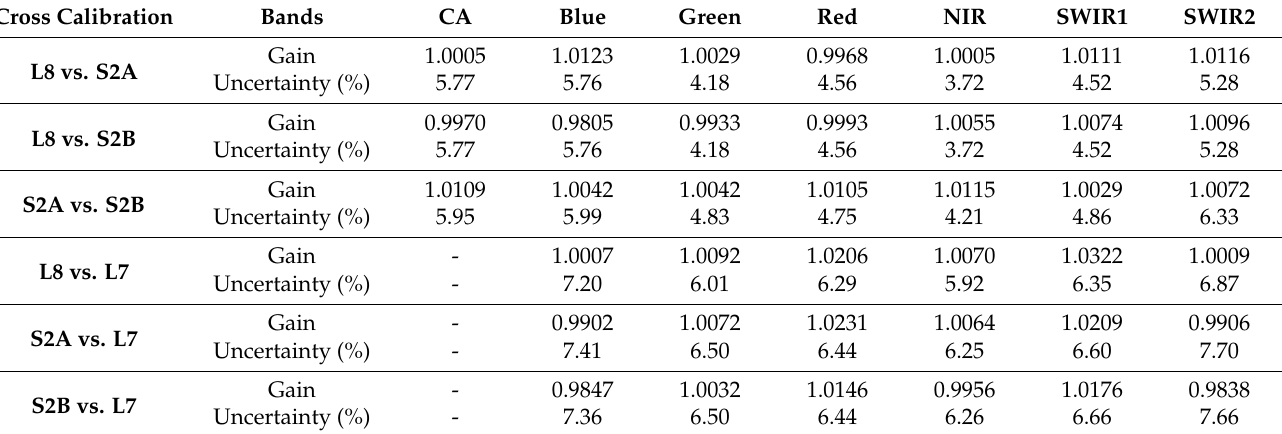
Table 3. The trend-to-trend cross-calibration